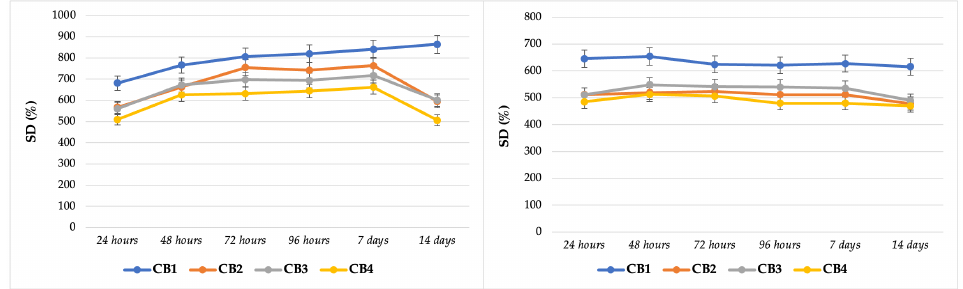
Figure 7. Swelling in HBSS ( left ) and DMEM ( right ) .